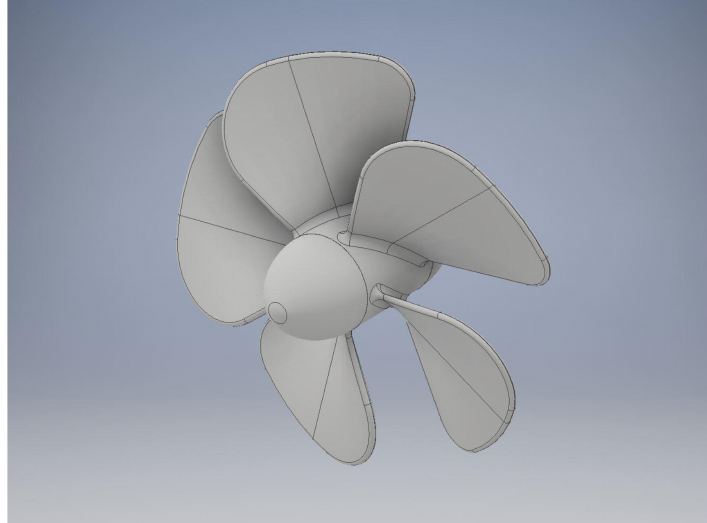
Figure 1. Parametric 3D model of the propeller.